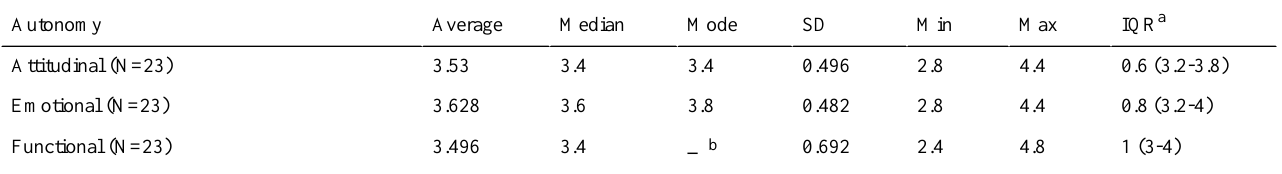
Table 9. Attitudinal, emotional, and functional autonomy among children who attended the conference